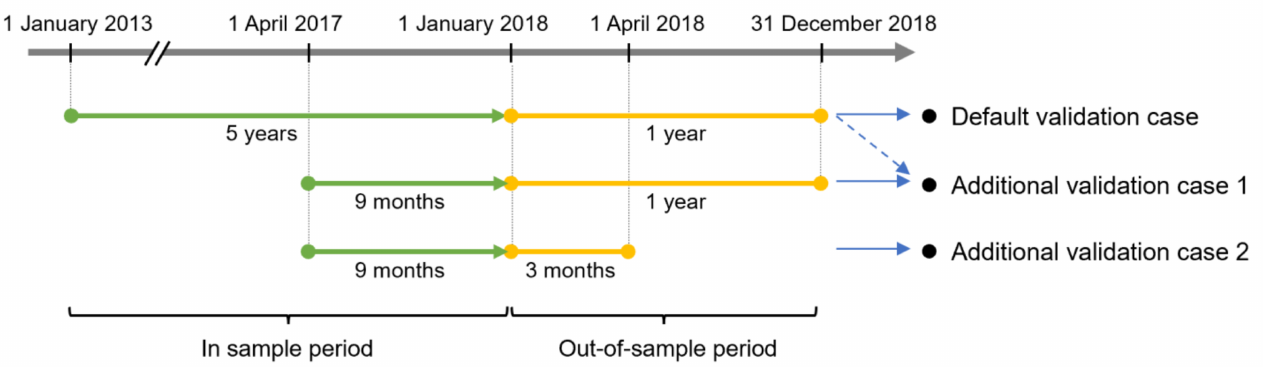
Figure 5. The relationship between in-sample and out-of-sample periods of each validation case for the individual PV power generation forecasting model. Note: “Default validation case” corresponds to Figures 6 and 7 and Table 1; “Additional validation case 1” corresponds to Figures 8 and A2; “Additional validation case 2” corresponds to Figure